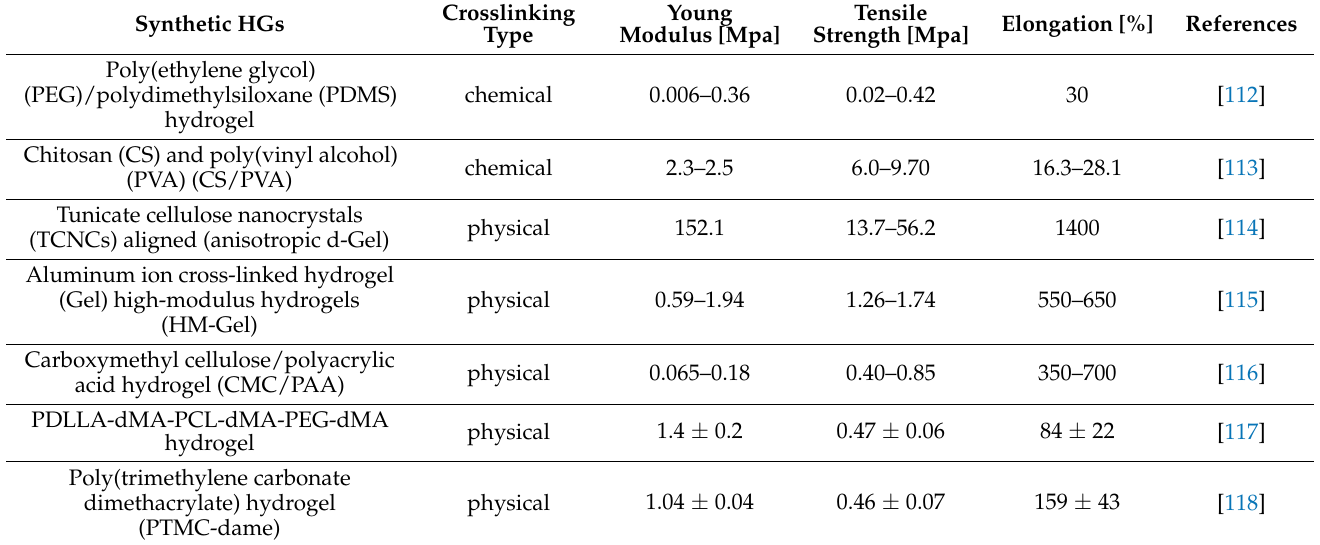
Table 4. Mechanical properties of commonly used